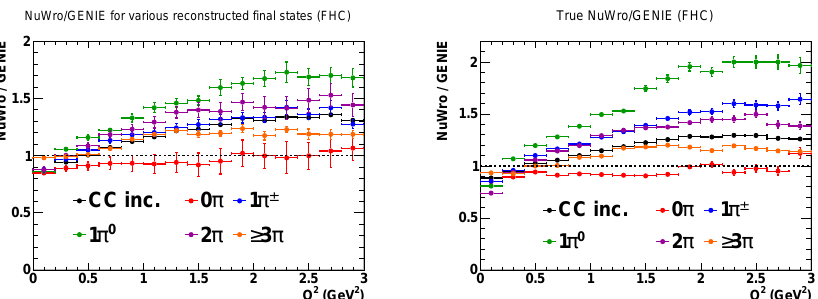
Figure 68. ( Left ): Reconstructed ratios of the NuWro-reweighted HPgTPC ν µ sample to the nominal GENIE sample, separated by pion multiplicity. ( Right ): The true ratios separated by pion multiplicity. Shown also is the same ratio for all reconstructed charged current muon neutrino events. These ratios were made for the FHC beam. The study discussed in the text also uses similar ratios for the RHC beam.